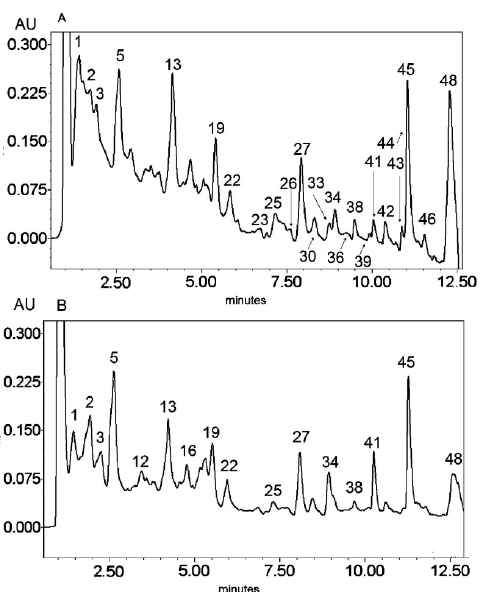
Figure 1. UV chromatogram of the E1 extract from Platycodon grandiflorum A. DC recorded at λ = 230 nm ( A ) and λ = 280 nm ( B ) by UPLC system. Chromatographic profiles of metabolites were obtained with gradients of two solvents: A (water acidified with 0.1% formic acid) and B (100% acetonitrile), mobile phase flow of 0.4 mL/min on a RP C18 column at 40 °C. The gradient elution: 100% of A linearly changed to 80% of A over 2 min, then to 70% of A over 8 min and to 5% of A over 1 min. The number corresponded to numbers of identified metabolites in Table 2.